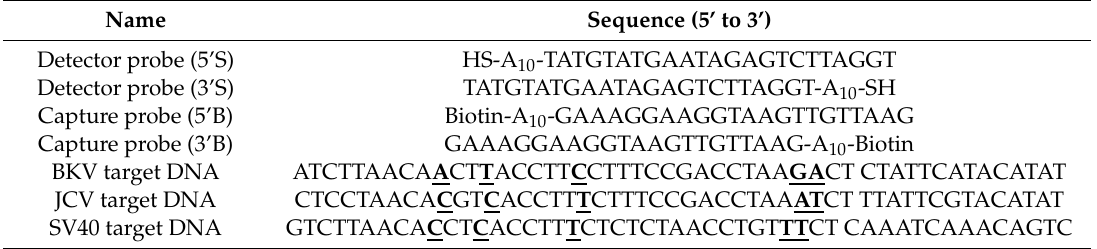
Table 1. Oligonucleotide sequences used for the development of nucleic acid lateral flow